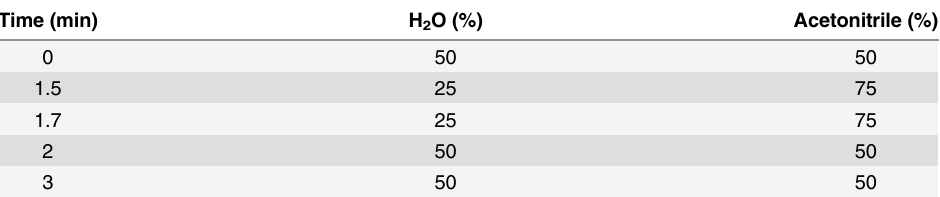
Table 1. HPLC gradient profile for the detection of